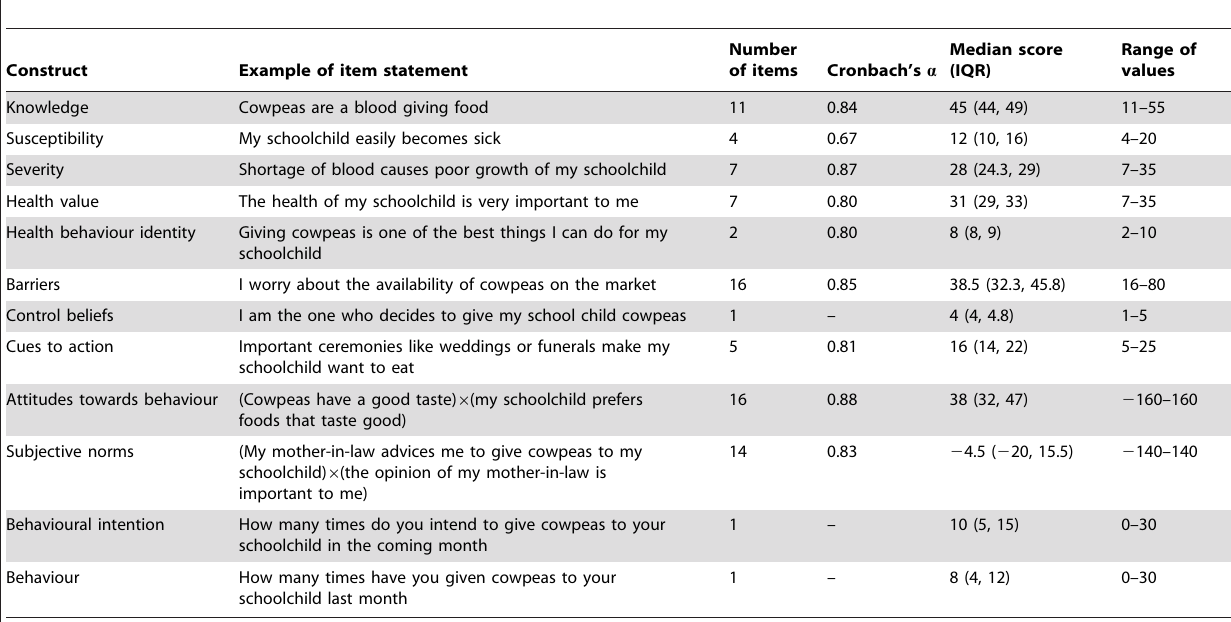
Table 5. Sample item statements, number of items, reliability and summary values of the constructs from the combined model of the Theory of Planned Behaviour and the Health Belief